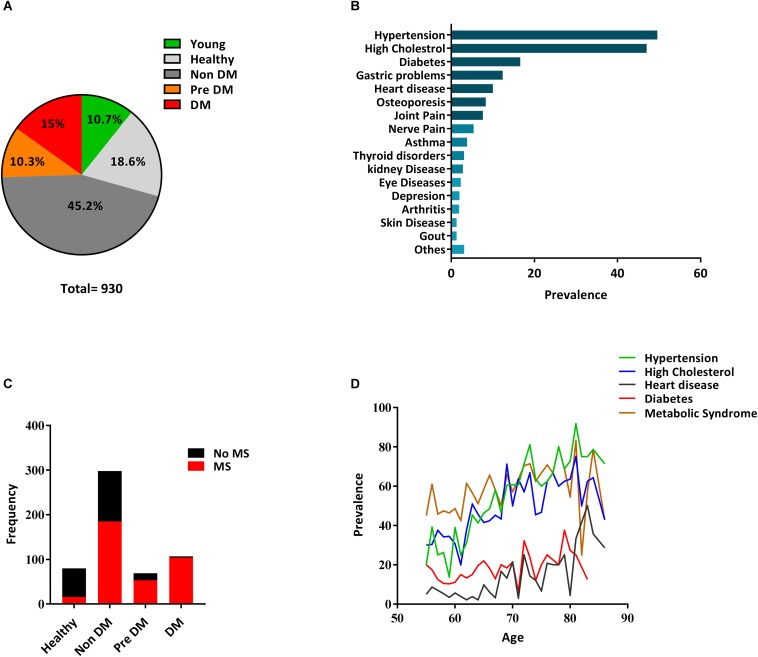
Distribution of diabetes and other diseases in the SLAS cohort. (A) A pie chart indicating the percentage of the individual in each group. (B) Prevalence of confirmed medical conditions in the SLAS cohort. Others indicate [skin disease (1.67%), Gout (1.67%) chronic obstructive Pulmonary Disease (0.76%), Parkinson disease (0.3%), Anemia (1.2%), and Prostate cancer (1.07%)]. (C) Cases of metabolic syndrome in the four groups using the updated NCEPATP III [National Cholesterol Education Program (NCEP) Adult Treatment Panel III (ATP III)] criteria. The Proportion of Metabolic syndrome within Healthy, Non-DM, Pre DM, and DM group is 20, 62, 76.8, and 97.2%, respectively. (D) Age-dependent Prevalence of Diabetes, Hypertension, Heart Disease, High Cholesterol, and Metabolic Syndrome in the SLAS cohort.